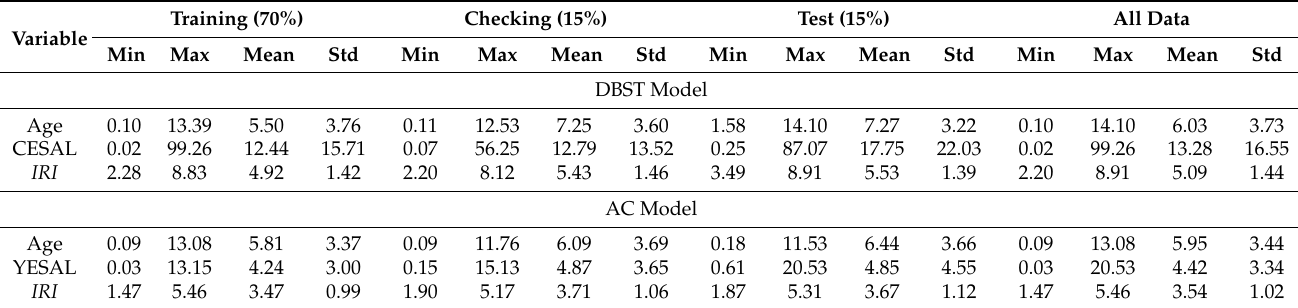
Table 2. Descriptive statistics of the variables used for IRI